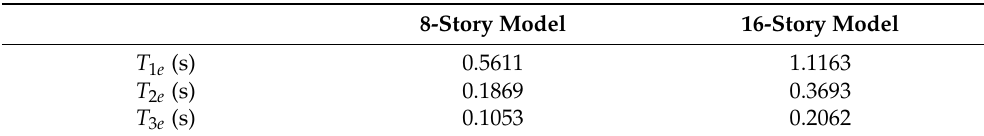
Table 1. Natural period of the models at the initial